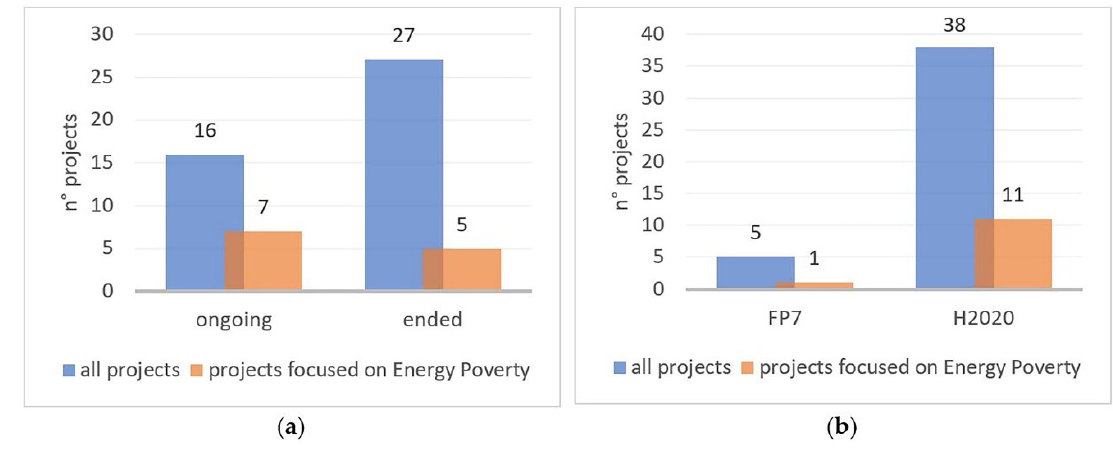
Figure 1. ( a ) Number of projects ongoing and ended; ( b ) number of projects per EU Research and Innovation program. Image elaborated by the authors.